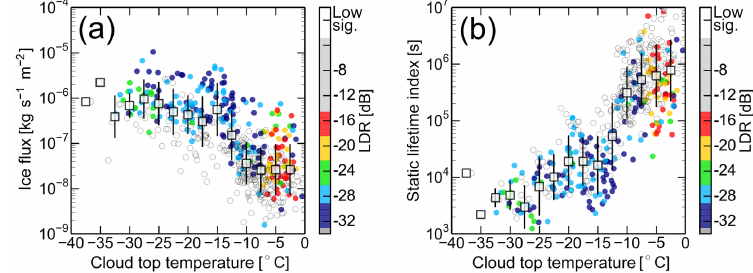
Figure 10. (a) The ice mass flux at cloud base. (b) The estimated static lifetime index T l = LWP /F of each